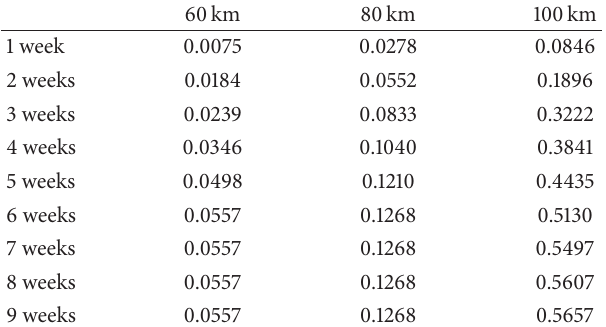
Table 3: AE as precursor from July 5, 2011 to September 5, 2011. Cumulative probability 𝐶 + ( r, 𝜏 ) for radius r ranging between 60 and 100km, and time 𝜏 varying from 1 week to 9 weeks.